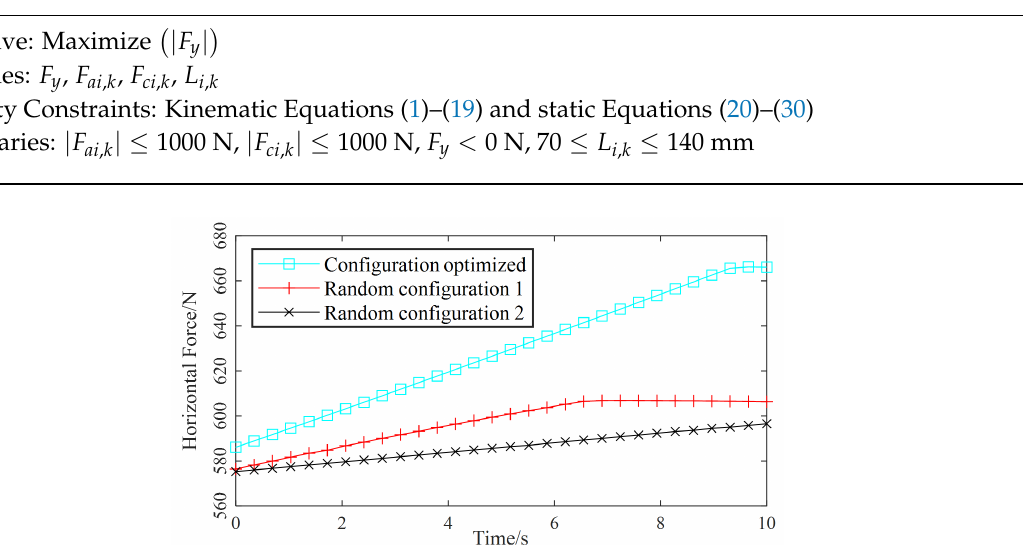
Figure 6. Comparison of the maximum reachable horizontal forces obtained by different configurations along the same given